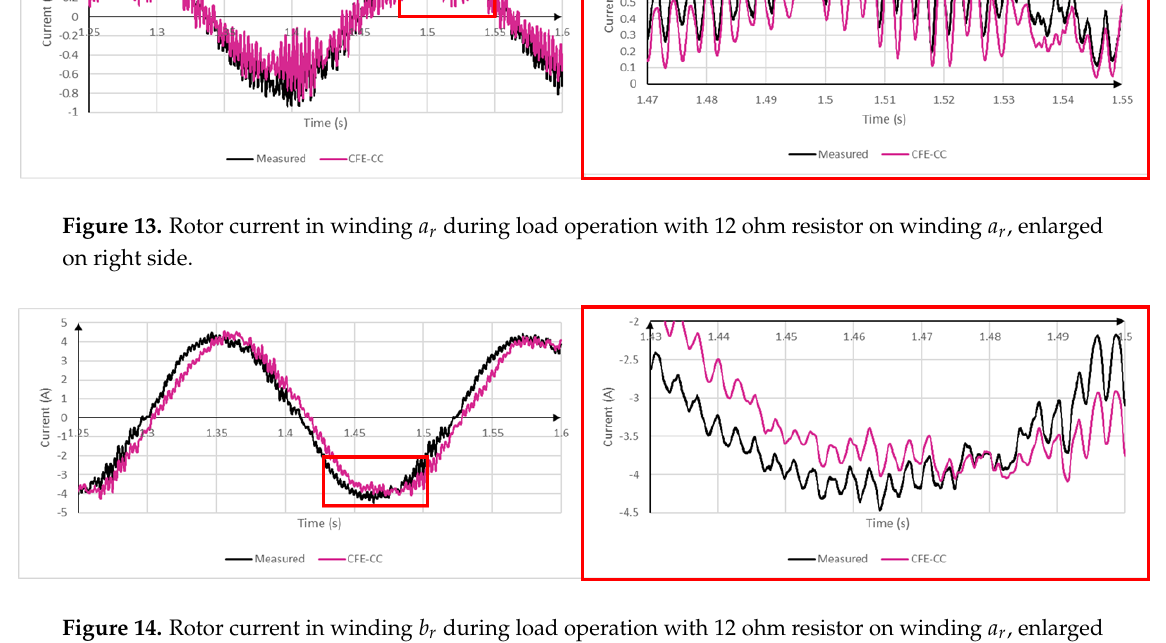
Figure 14. Rotor current in winding b r during load operation with 12 ohm resistor on winding a r , enlarged on right side.